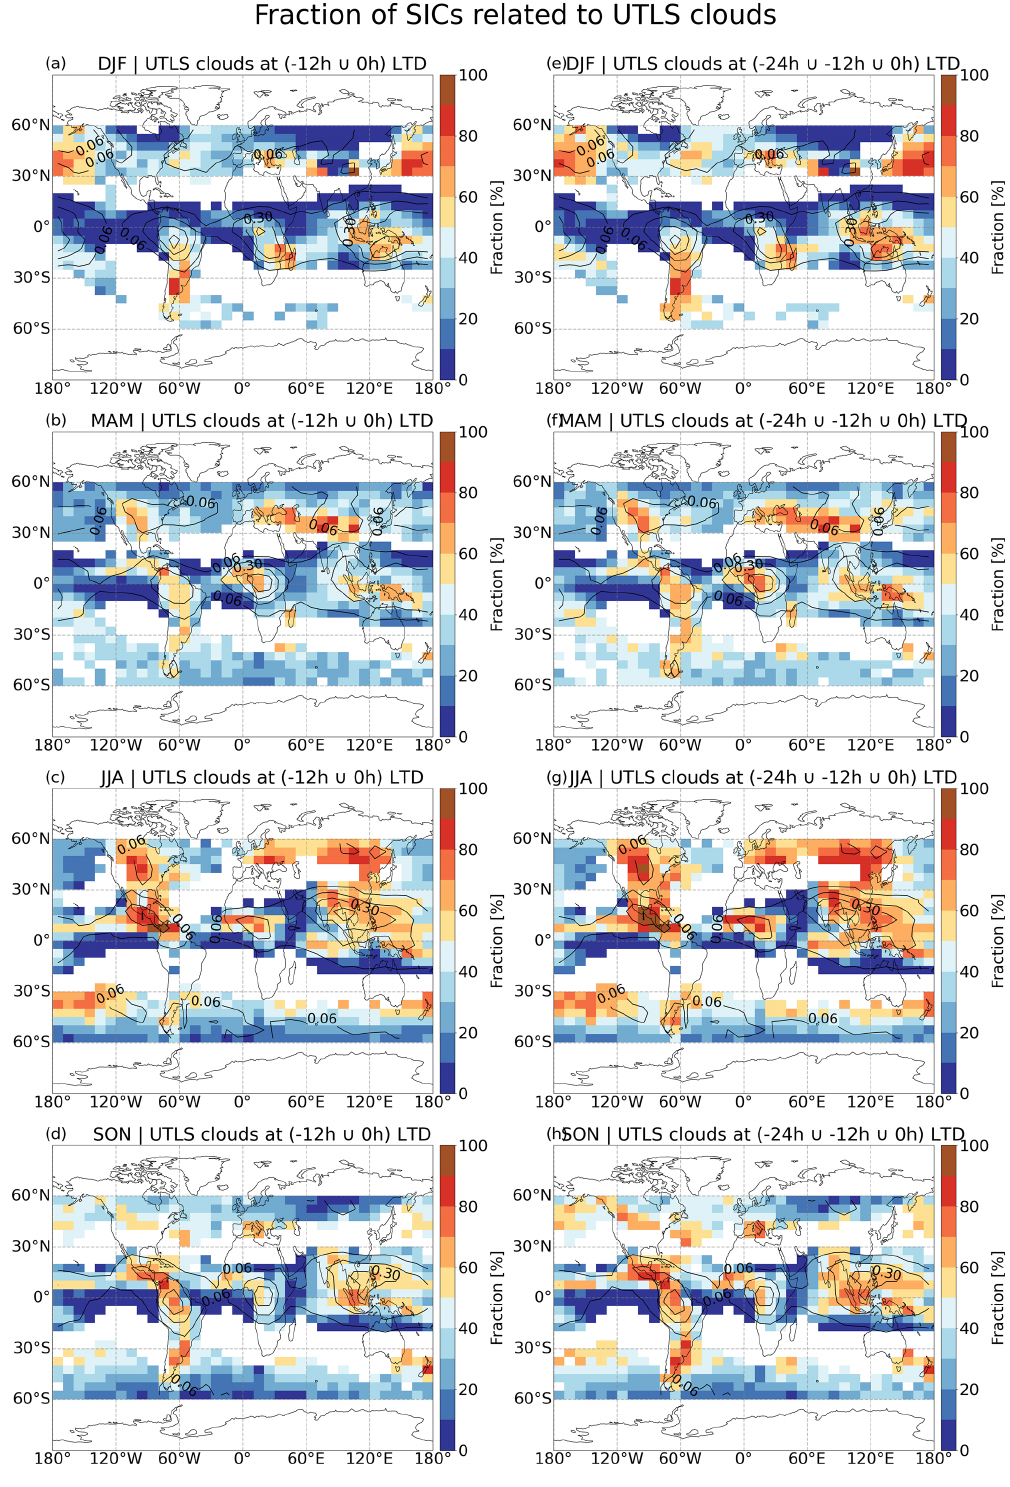
Figure C1. Fraction of SICs related to UTLS clouds, with UTLS clouds observed by AIRS measurements 12h ( − 12LTD) and 24h ( − 24LTD) before the SIC detection. The occurrence frequency of SICs shown in the black contours are based on the data presented in Fig.